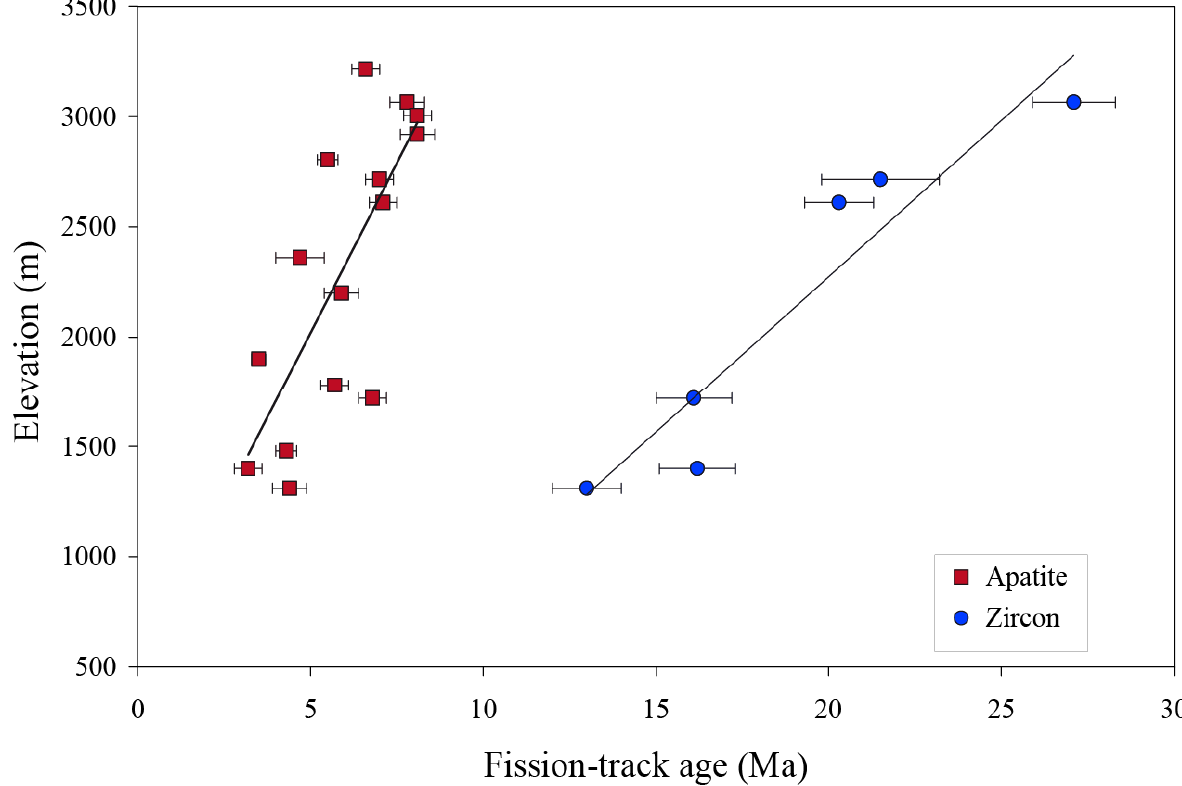
Figure 3. La Meije bedrock apatite and zircon fission-track age-elevation plot. Data from